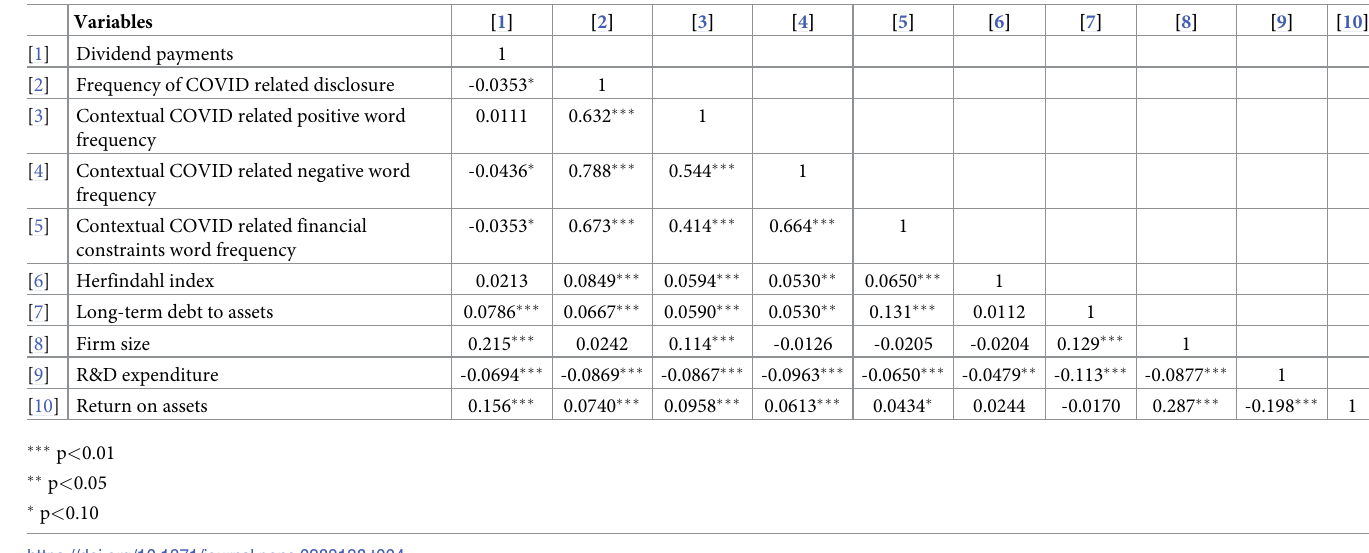
Table 4. Correlation